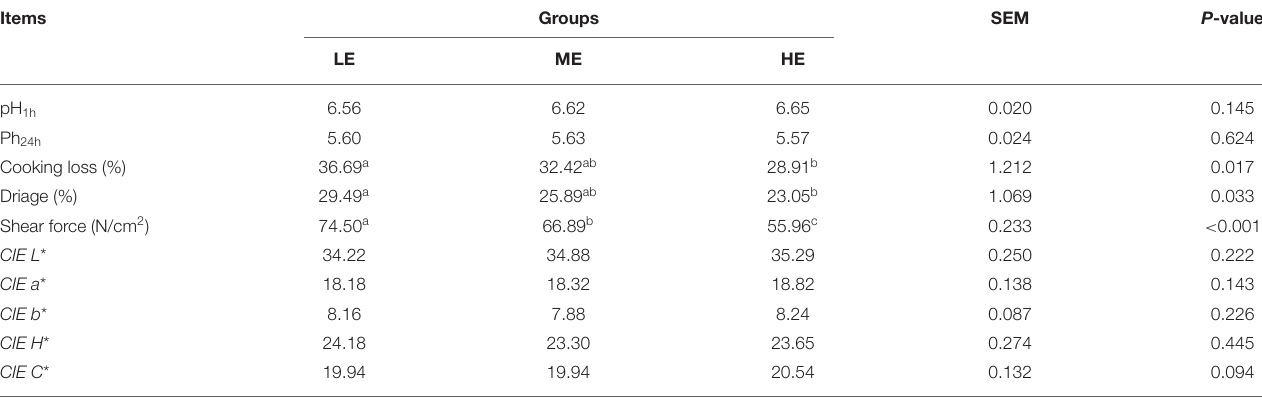
TABLE 2 | Effect of dietary energy levels on the quality in the longissimus thoracis muscle of